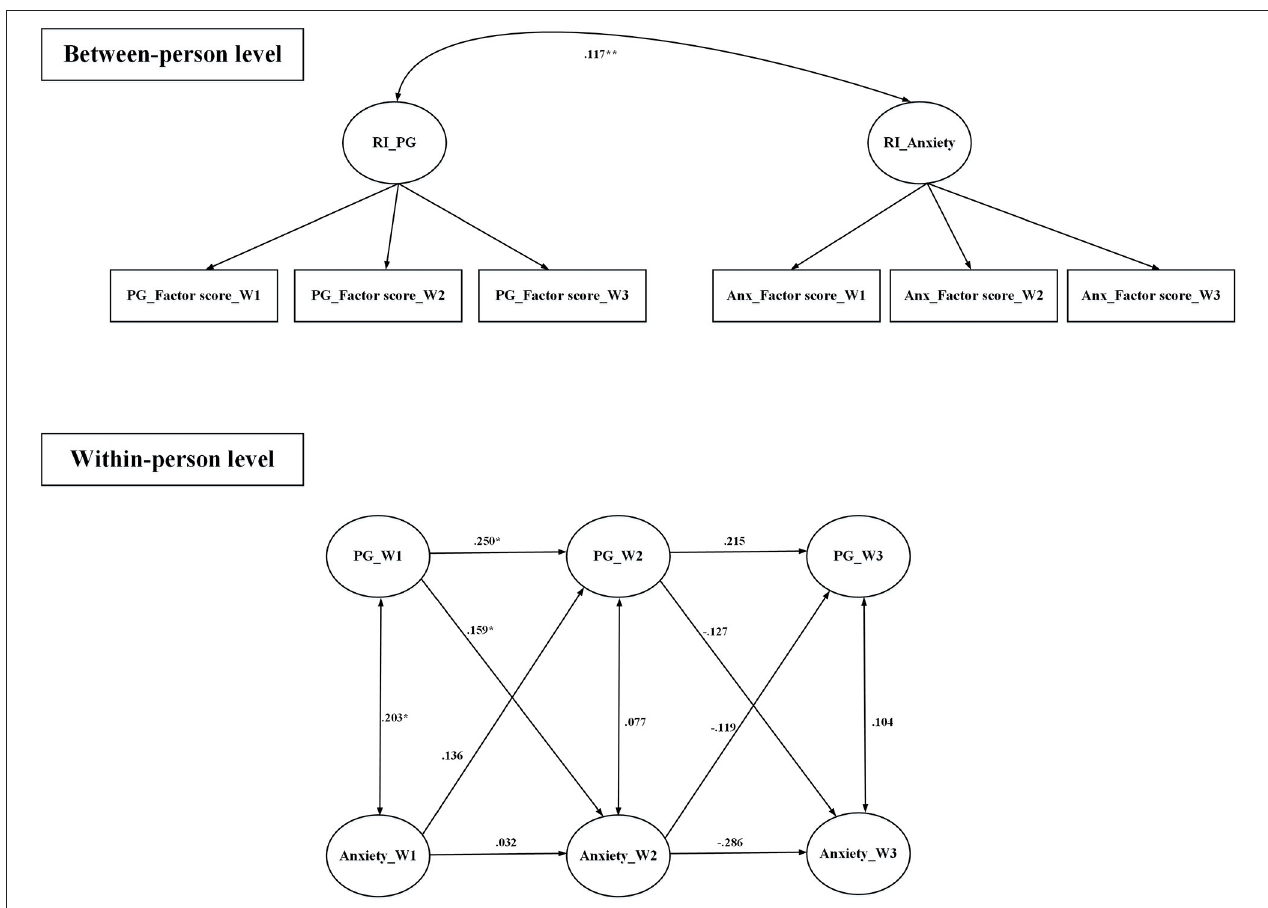
FIGURE 3 | Cross-lagged model of PG and anxiety using lagged bidirectional model. Covariates include gender and age. Anxiety was assessed using the Hospital Anxiety and Depression Scale; PG, problematic gaming was assessed using the Internet Gaming Disorder Scale-Short Form. RI, random intercept; W1, wave 1; W2, wave 2; W3, wave 3. All the estimates are standardized coefficients. * p < 0.05; ** p <